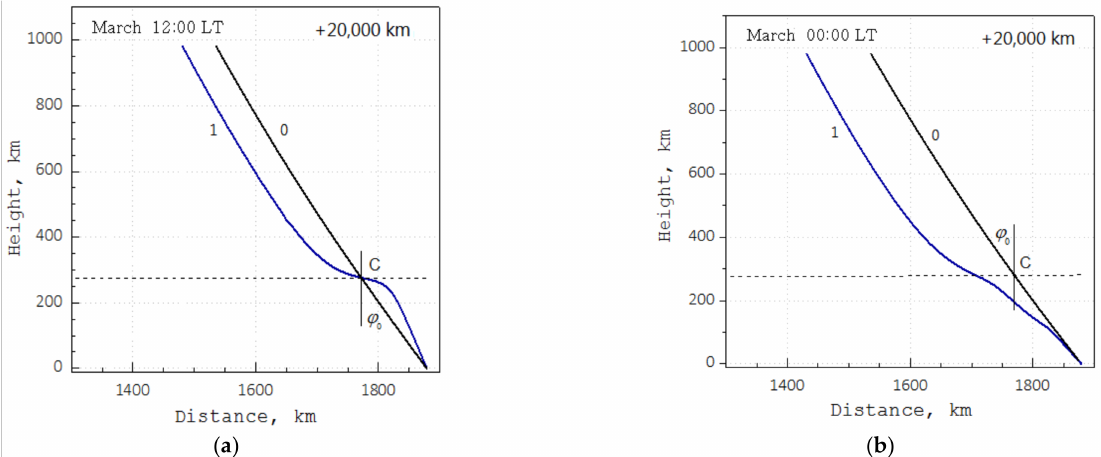
Figure 3. Ray paths in the plane of the geomagnetic meridian corresponding to the optical direction of the satellite (line 0) and for frequencies near the radio transparency boundary (curves 1): ( a ) Local noon; ( b ) local midnight. The dotted curve shows a position of the main ionospheric maximum,